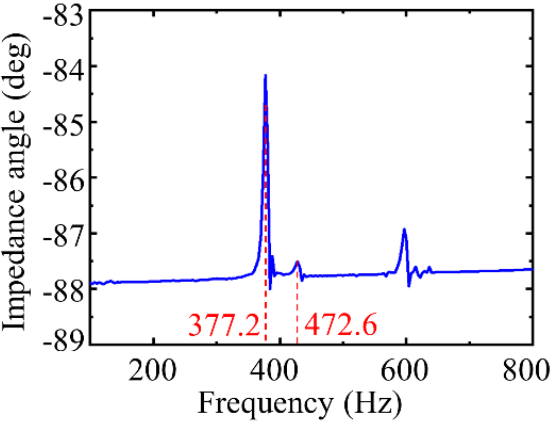
Figure 11. Frequency response of the actuator. Square wave signals of the same frequency and different amplitudes were applied to the PZT stack to test the response speed of the driver. After FFT low-pass filtering, the displacement curve is displayed in Figure 12. The response time of the actuator was kept within the range of 10 ms under different step voltages.